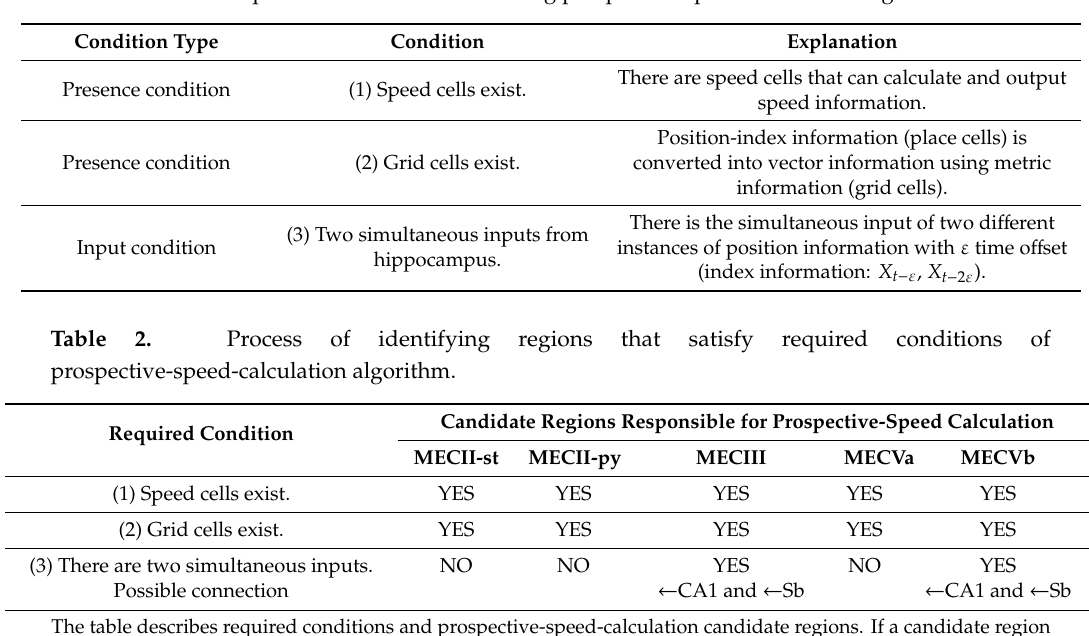
Table 2. Process of identifying regions that satisfy required conditions of prospective-speed- calculation algorithm.